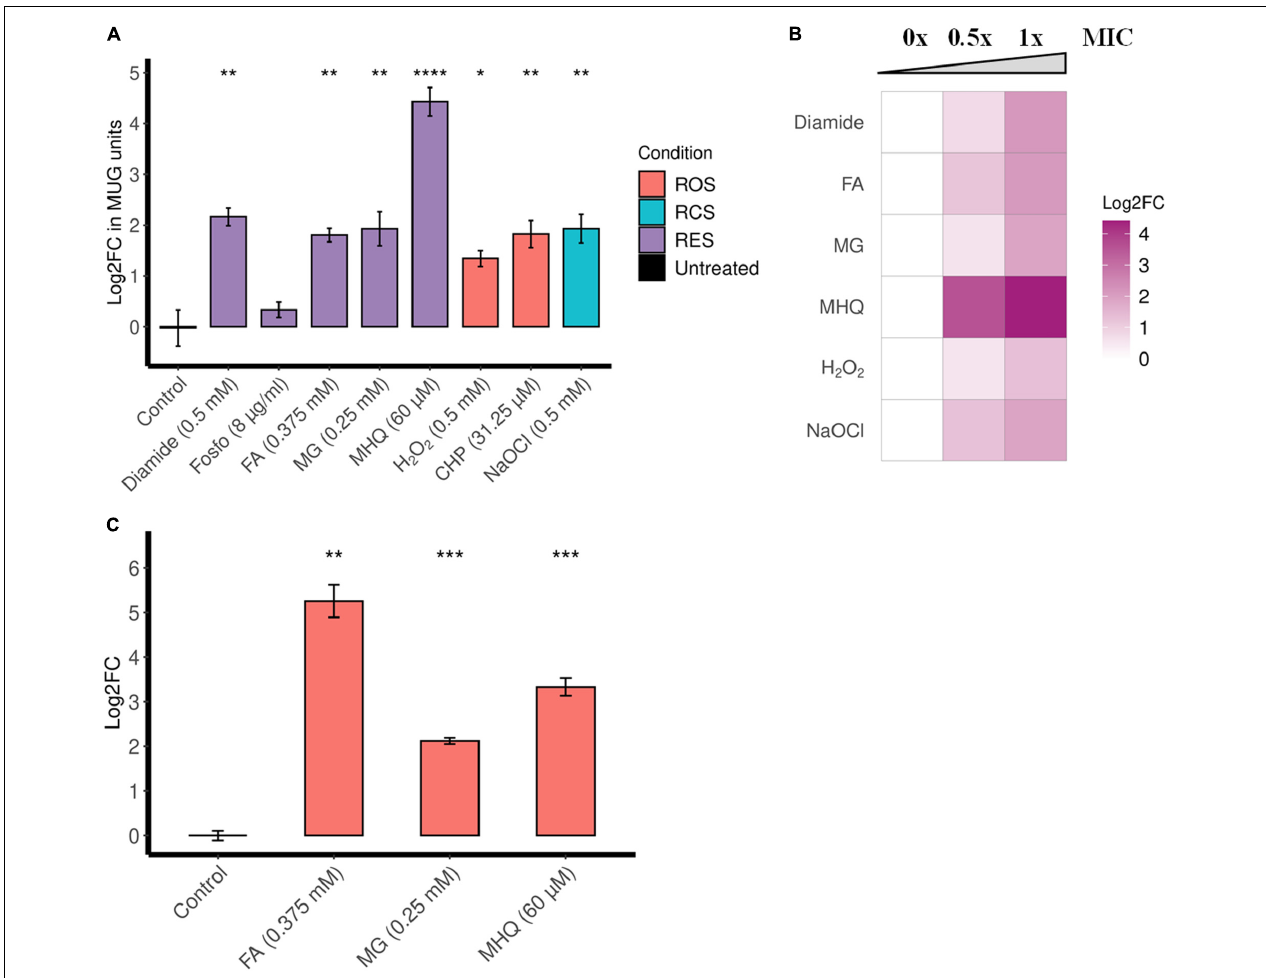
FIGURE 2 | ofrA is induced in RES, ROS, and RCS in a dose-dependent manner. (A) ofrA induction conditions using the reporter strain EI011, which harbors a chromosomally encoded lacZ under P ofrA ( Supplementary Figure 3 ). After 2-h incubation with shaking at 37 ◦ C, β -galactosidase assay was used to report ofrA transcriptional level. The corresponding concentrations were indicated in the graph. A total of four biological replicates were compared to untreated controls using unpaired two-tailed Student’s t -test. Error bars represent the standard error of the means. (B) Dose dependency of ofrA induction using β -galactosidase assays. The highest concentration is the minimum inhibitory concentration (1 × MIC), the intermediate concentration is 0.5 × MIC, and compared to control (no compounds were added = 0 × MIC). Log2FC was calculated as average from three biological replicates. (C) RT-qPCR shows ofrA induction in S. aureus JE2 background in agreement with the reporter system. JE2 strain was cultivated in RPMI until mid-logarithmic phase (OD 600 = 0.5). Samples were taken before adding the compounds as a control. After adding the compounds, the bacterial pellets were collected after 15 min of incubation at 37 ◦ C with shaking. A total of three biological replicates were compared to untreated controls via unpaired two-tailed Student’s t -test. Error bars represent the standard error of the means. * p < 0.05; ** p < 0.01; *** p < 0.001; **** p < 0.0001. CHP, cumene hydroperoxide; FA, formaldehyde; Fosfo, fosfomycin; MG, methylglyoxal; MHQ, methylhydroquinone; MIC, minimum inhibitory concentration; RCS, reactive chlorine species; RES, reactive electrophilic species; ROS, reactive oxygen